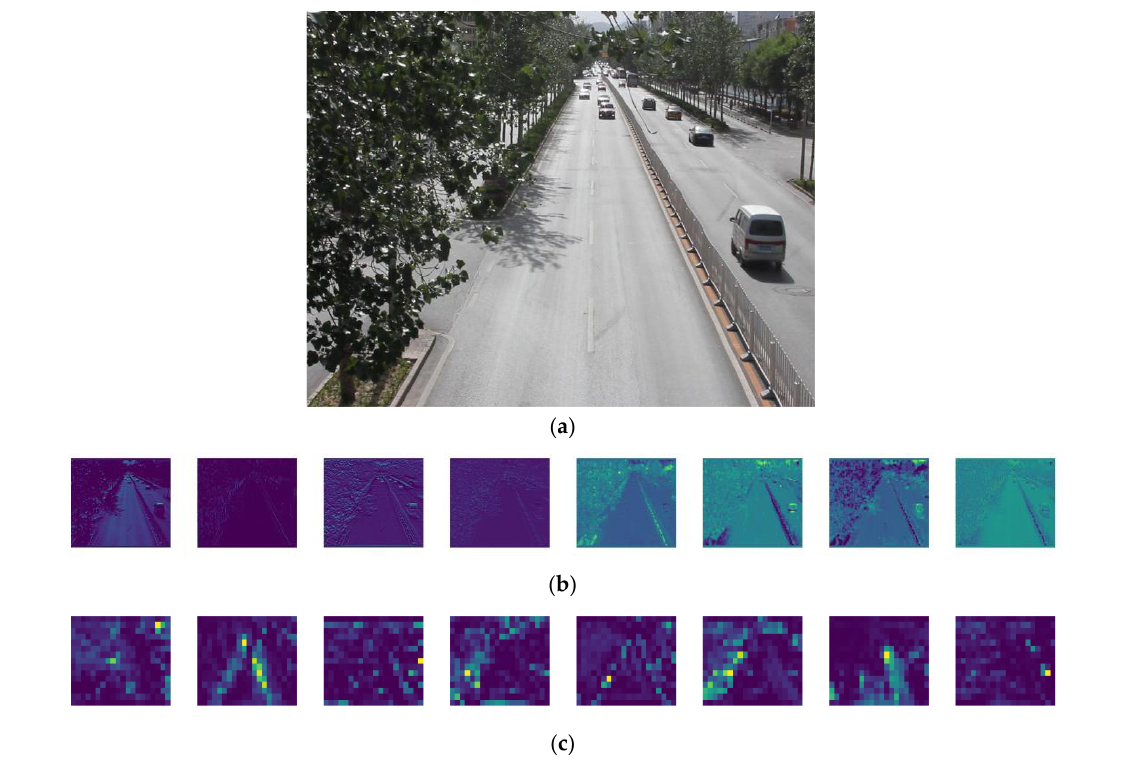
Figure 12. Visual feature map: ( a ) original image; ( b ) stage0_ Conv_ features; ( c ) Backbone_ Conv_ last layer_features.